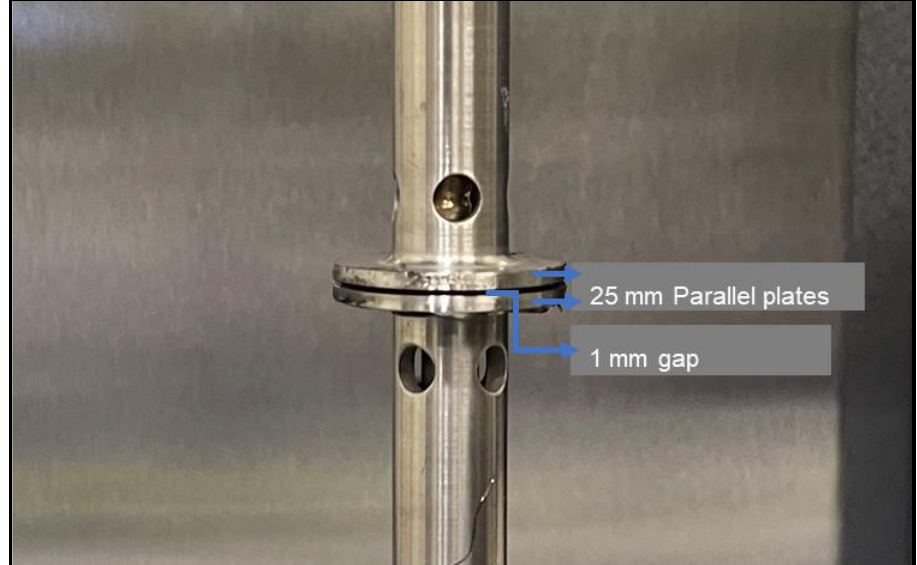
Figure 5. The pair of parallel plates of 25 mm diameter with a 1 mm gap in between.